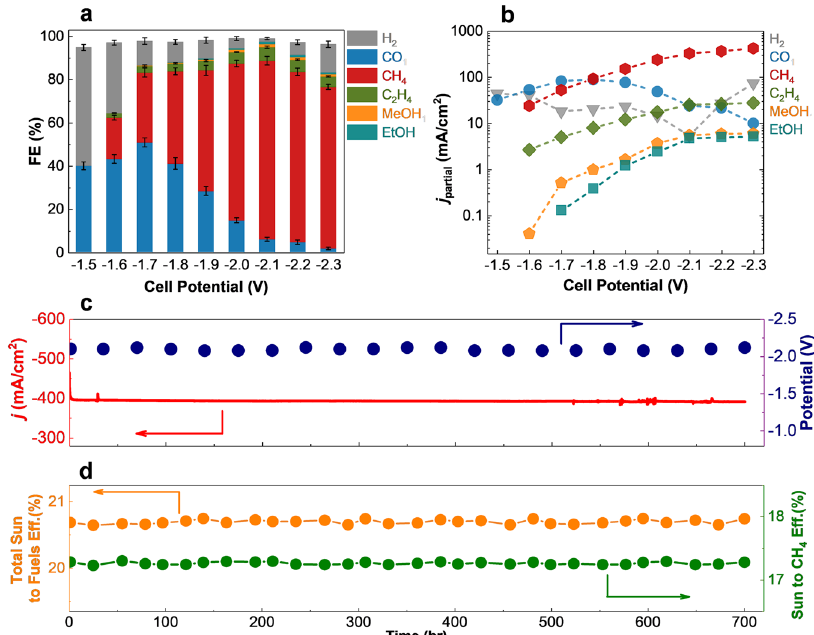
Fig. 5 Electrocatalytic performance and stability of W 2 C NFs in the solid polymer electrolyte fl ow electrolyzer. a Faradaic ef fi ciency (FE) measurements of H 2 , CO, CH 4 , C 2 H 4 , methanol (MeOH), and ethanol (EtOH) for W 2 C NFs at different cell potentials. The error bars represent standard deviations of four independent experiments. b Partial current density for each product as a function of cell potential. The values are obtained considering the total current density and faradaic ef fi ciencies of products at the entire range of cell potential. c Measured total current densities and cell potentials of the solar-driven solid polymer electrolyte fl ow electrolyzer under one sun illumination provided by the TJ-PV cell over time. d Total sun to fuels ef fi ciency and sun to CH 4 production ef fi ciency in the solar-driven solid polymer electrolyte fl ow electrolyzer over